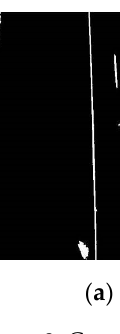
Figure 8. Comparison picture of binarization: ( a ) Binary image; ( b ) Binary matrix.